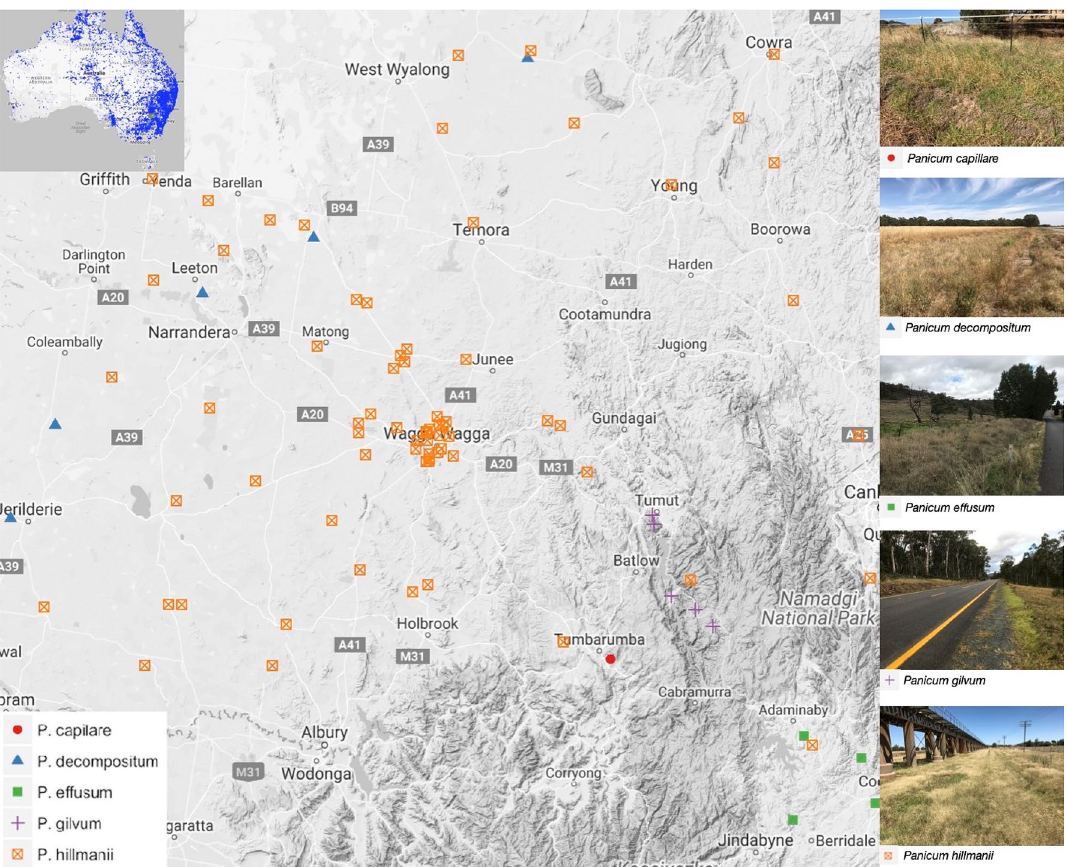
Figure 2. Location of field collected Panicum spp. within a 200 km radius of Wagga Wagga, New South Wales, Australia. Right: representative photos of collected plants in their habitats. Inset map: Distribution of recorded Panicum species in Australia (Australia Virtual Herbarium Database, 2019).